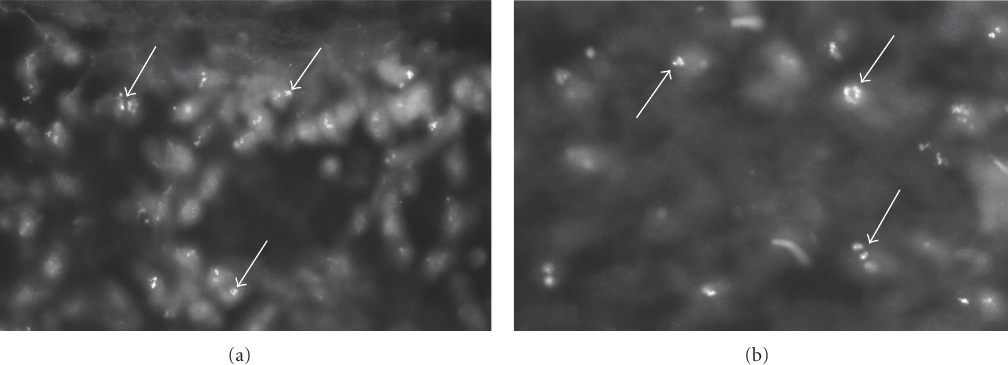
Figure 5: (a, b) Sections of myositis specimens after processing for TNF-alpha. Cells show specific immunoreactions (arrows). The reactions show a granular appearance.